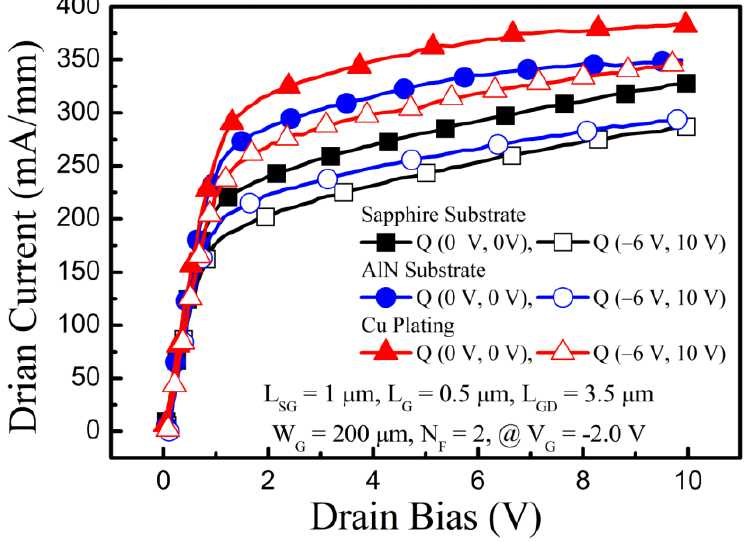
Figure 6. Pulse-mode stress measurement results in GaN-based HEMTs operated on sapphire